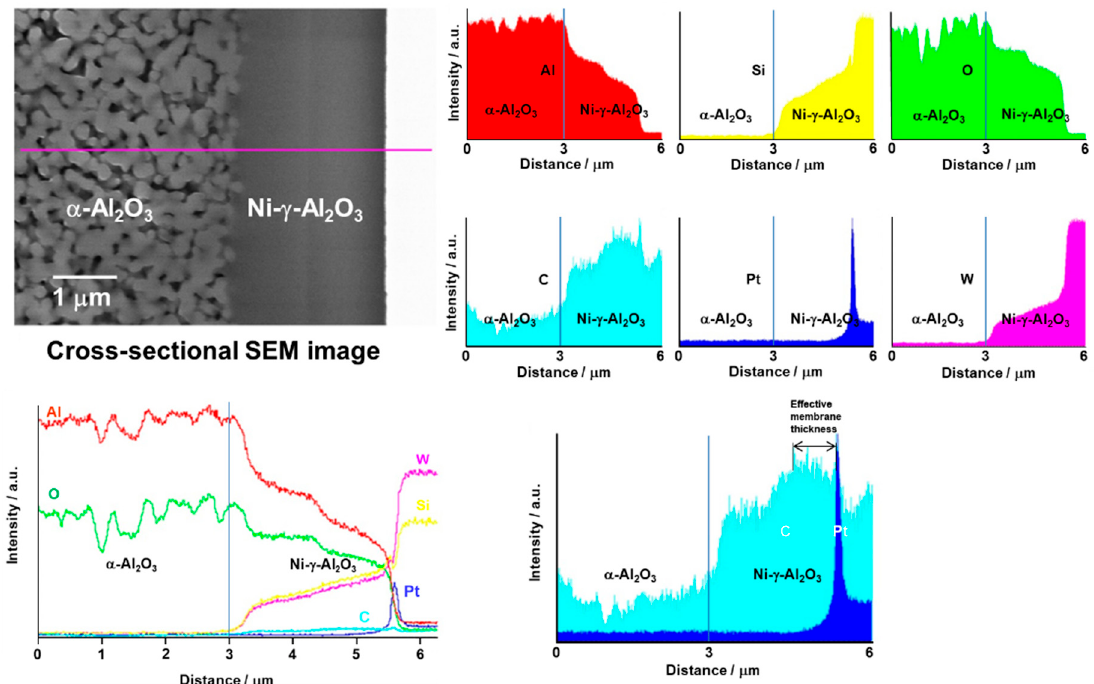
Figure 6. SEM image and EDS line analysis for SiC / Ni- γ -Al 2 O 3 / α -Al 2 O 3 membrane.